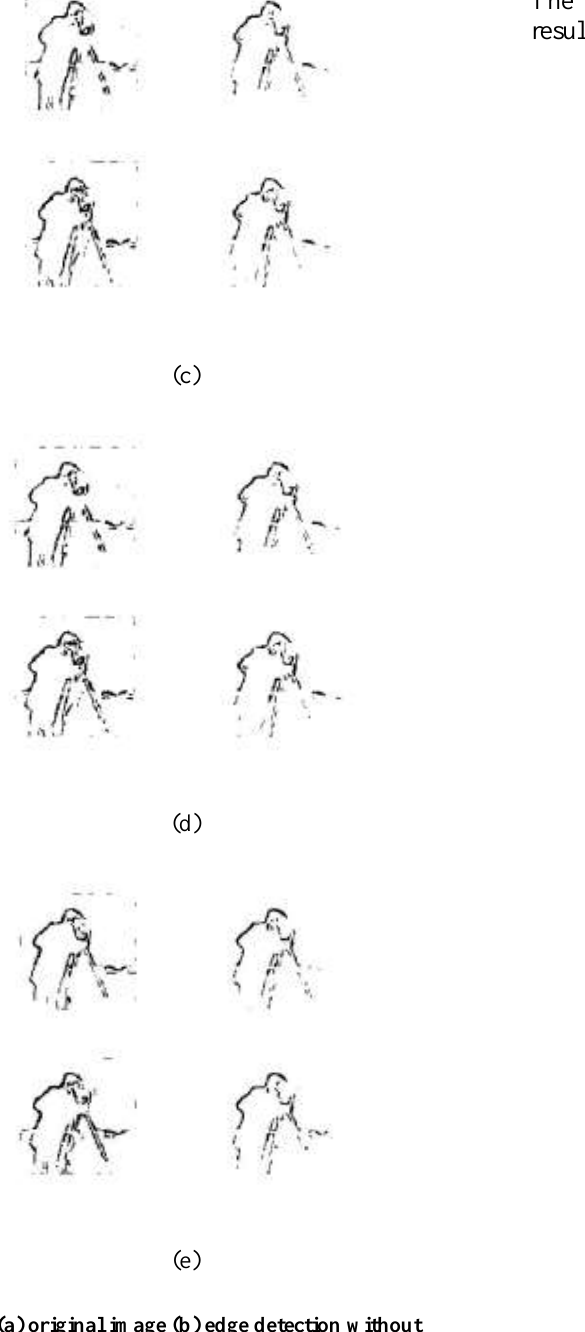
Figure 2. (a) original image (b) edge detection without noise (c) edge detection with salt and pepper noise and intensity= 0.02 (d) edge detection with salt and pepper noise and intensity=0.05 (e) edge detection with Gaussian noise and Intensity=0.05.